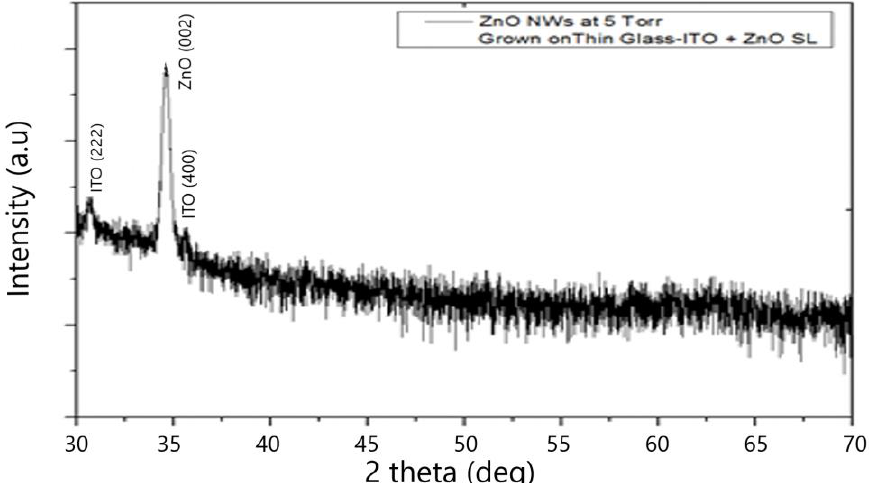
Figure 3. XRD Spectrum of ZnO Nws grown on Glass-ITO + ZnO SL at 10 Torr, Tsub < 500 °C d target – substrate = 6.5 cm, JCPDS card for ZnO file number: 070-8070.